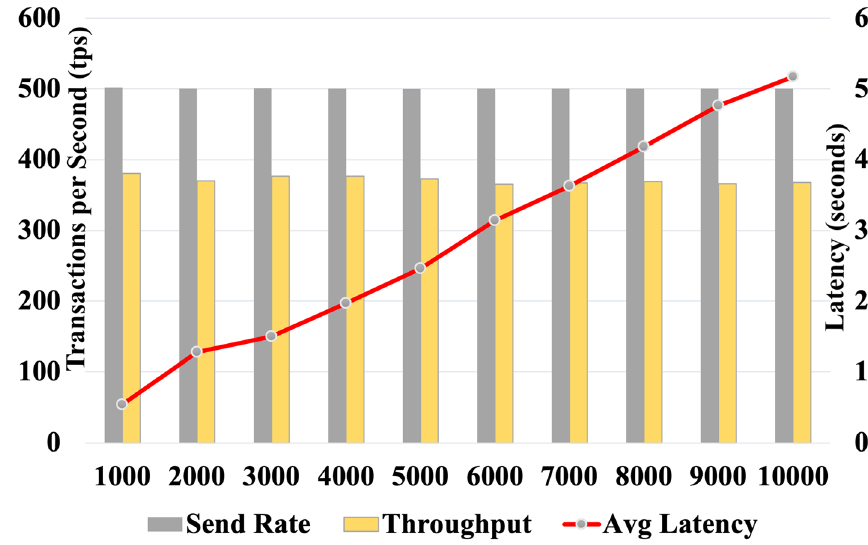
Fig. 16 Algorithm 2 performance: processing received metrics at fixed rate of 500 transactions and variable total transactions